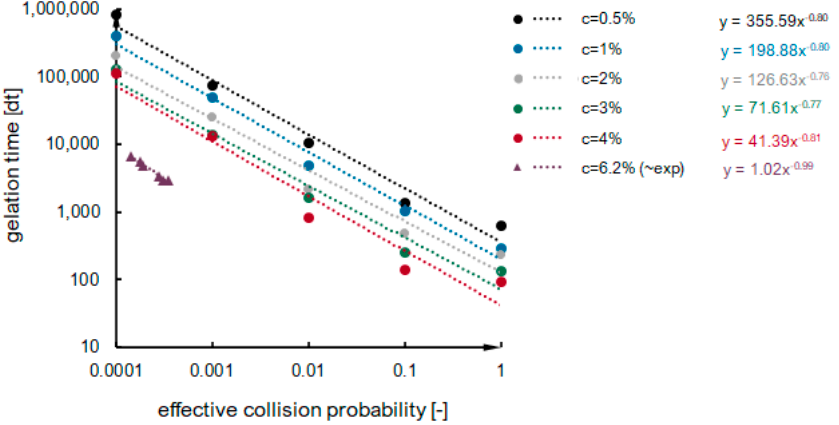
Int. J. Mol. Sci. 2023 , 24 , x FOR PEER REVIEW Figure 12. The values of maximum condensation rate obtained for numerical simulations.